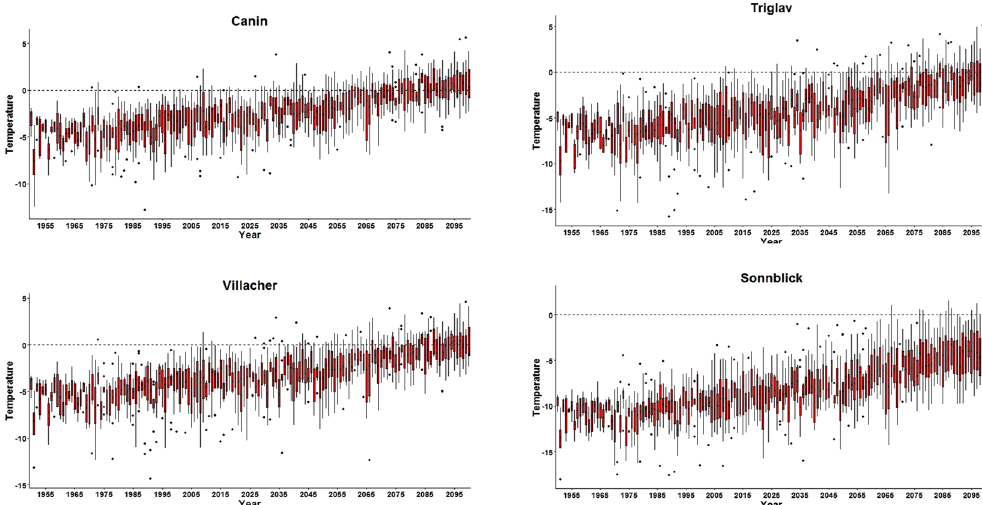
Figure 5. Historical and future December mean temperature (1950–2100, RCP8.5) at the grid points closest to the locations of the four mountain sites of Fig. 1, as simulated by the ensemble of RCMs in Supplementary Table 1, and after a topographical correction is applied (see text). The bar and whiskers plots show the inter- model median, 25th and 75th percentiles and maximum and minimum values in the ensemble. If the distance of a given value from the median is greater than 1.5 times the inter-quantile range, the corresponding value (considered as an outlier) is indicated with a